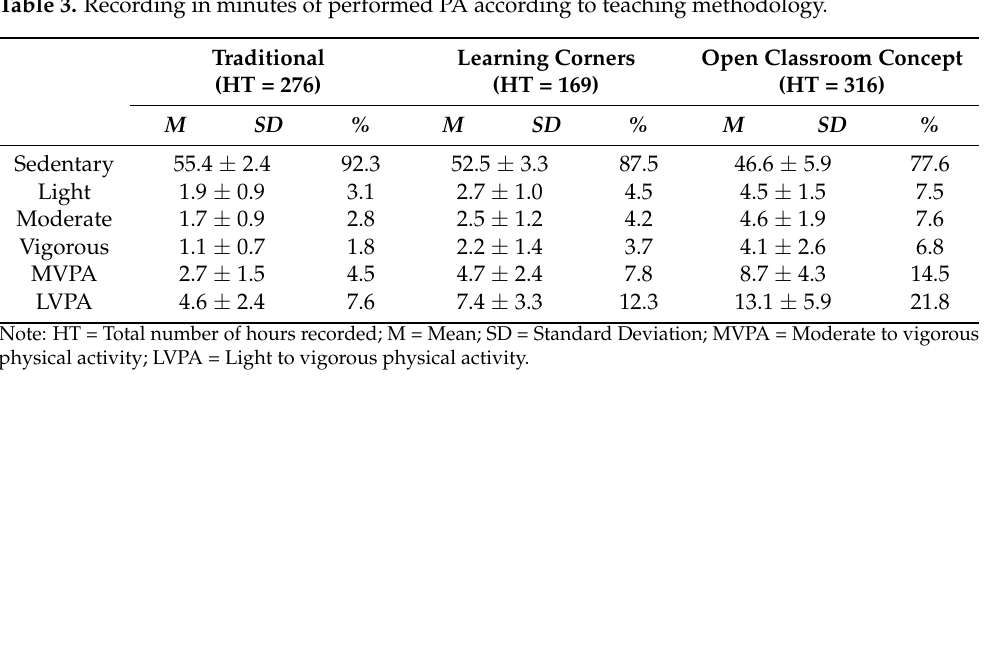
Table 3. Recording in minutes of performed PA according to teaching